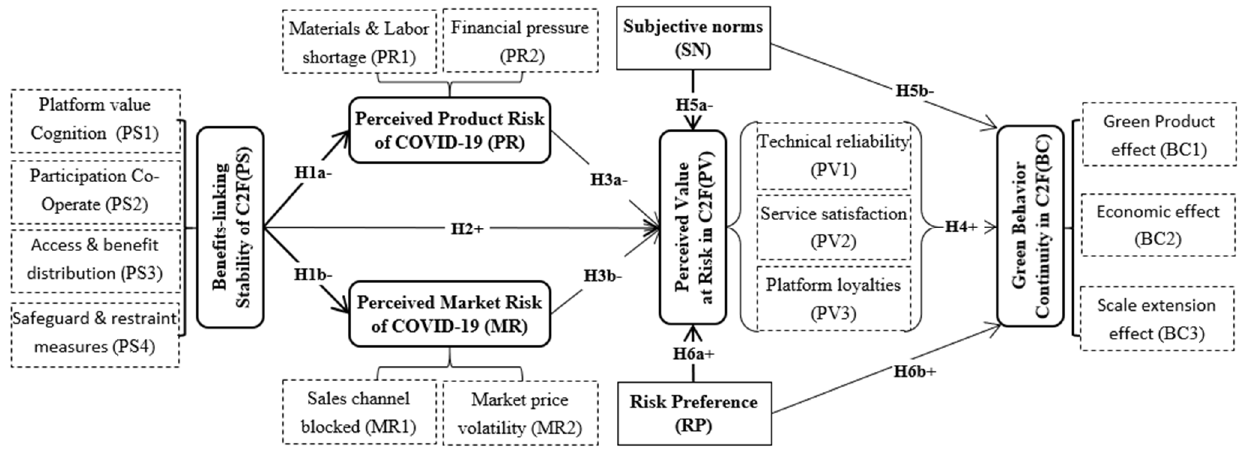
Figure 1. Research theoretical